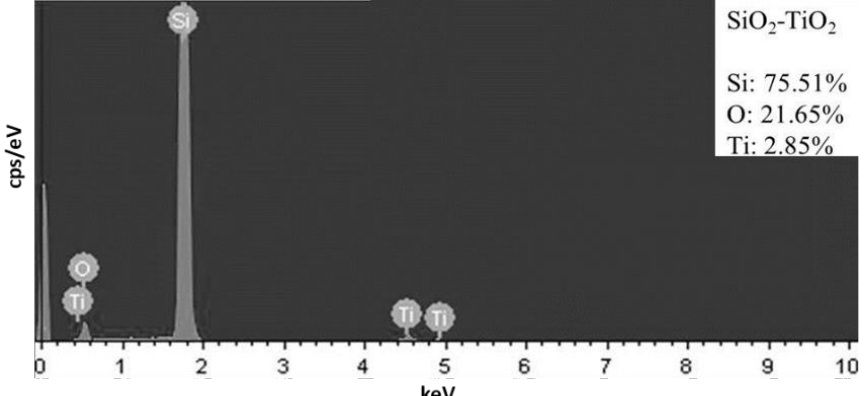
Figure 4. Energy dispersive X-ray spectroscopy (EDS) analysis of SiO 2 -TiO 2 coated diamond pillar arrays.